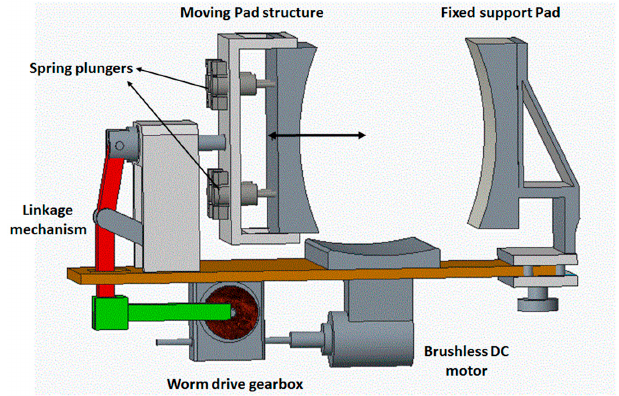
Figure 3. 3D CAD model of the knee-loading device.